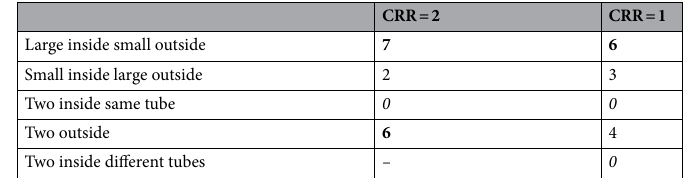
Table 1. Outcome of the two treatments of the manipulating competitor-to-resource ratio (CRR) experiment and results of the contingency analysis considering symbiont size. Bold: observed > theoretical; italics: observed < theoretical. H: host; S: